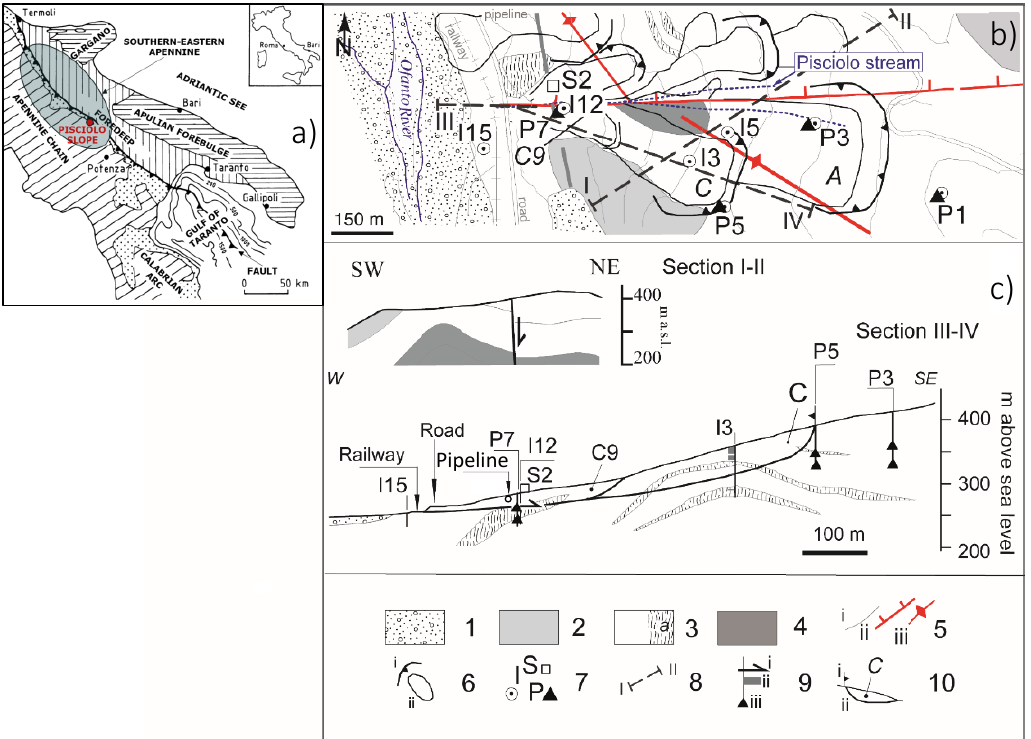
Figure 1. ( a ) Geological map of the Southern Italy, together with both the limited grey area representing the Southern-Eastern Apennine and the location of the Pisciolo slope. Geological map ( b ) and sections ( c ) of the Pisciolo slope (adapted from [3]); section I ‒ II is the geological section, whereas section III ‒ IV is the geotechnical one, whose traces are reported; Key: 1) debris and alluvial deposits; 2) N sandstones; 3) PD clays (a; fractured rock strata), 4) R clays; 5) stratigraphic contact (i), fault (ii) and anticline axis (iii); 6) landslide crown (i) and body (ii); 7) borehole with piezometers (P), or with inclinometer (I), GPS sensor (S2); 8) line of section; 9) inclinometer shear bending (i), disturbed soil (ii) and piezometer cell (iii); 10) labelled landslide — crown (i) and slip surface (ii) (Cotecchia et al. 2019).